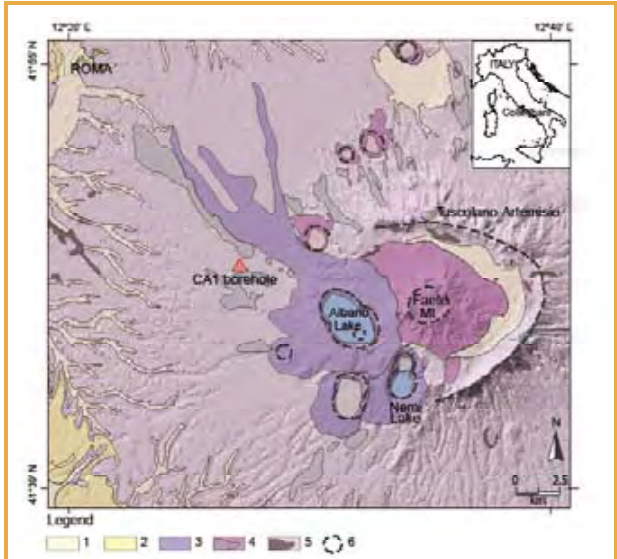
Figure 1. Geological map of Colli Albani area and CA1 borehole lo- cation. Color legend: 1) Holocene alluvial deposits; 2) Plio-Quater- nary sedimentary deposits; 3) “Hydromagmatic phase” (200-36 ky); 4) Deposits of “Faete phase” and related lava flows (308–250 ky); 5) “Tuscolano Artemisio phase” and related lava flows (561–351 ky); 6) Crater rims; (modified after Marra et al.,